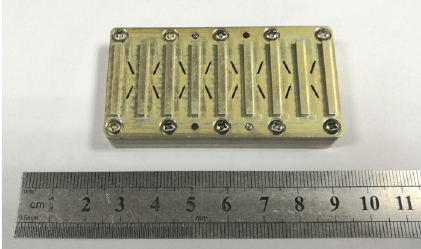
Figure 8: Photography of the fabricated 2 × 8 antenna array.